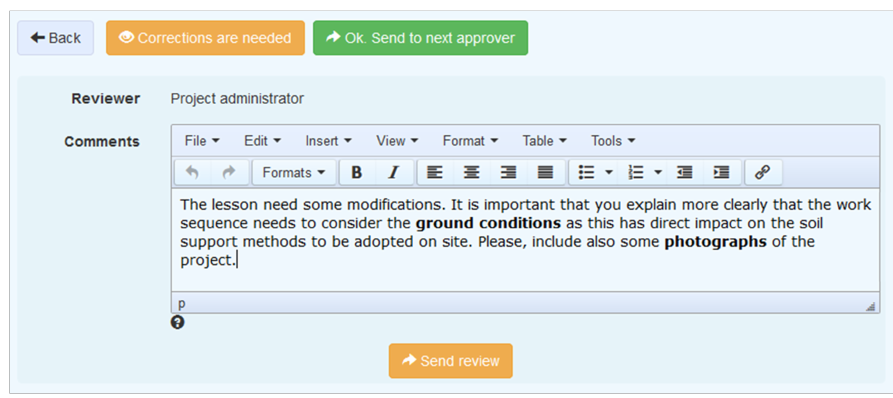
Figure 6. Screenshot of the web application showing the review